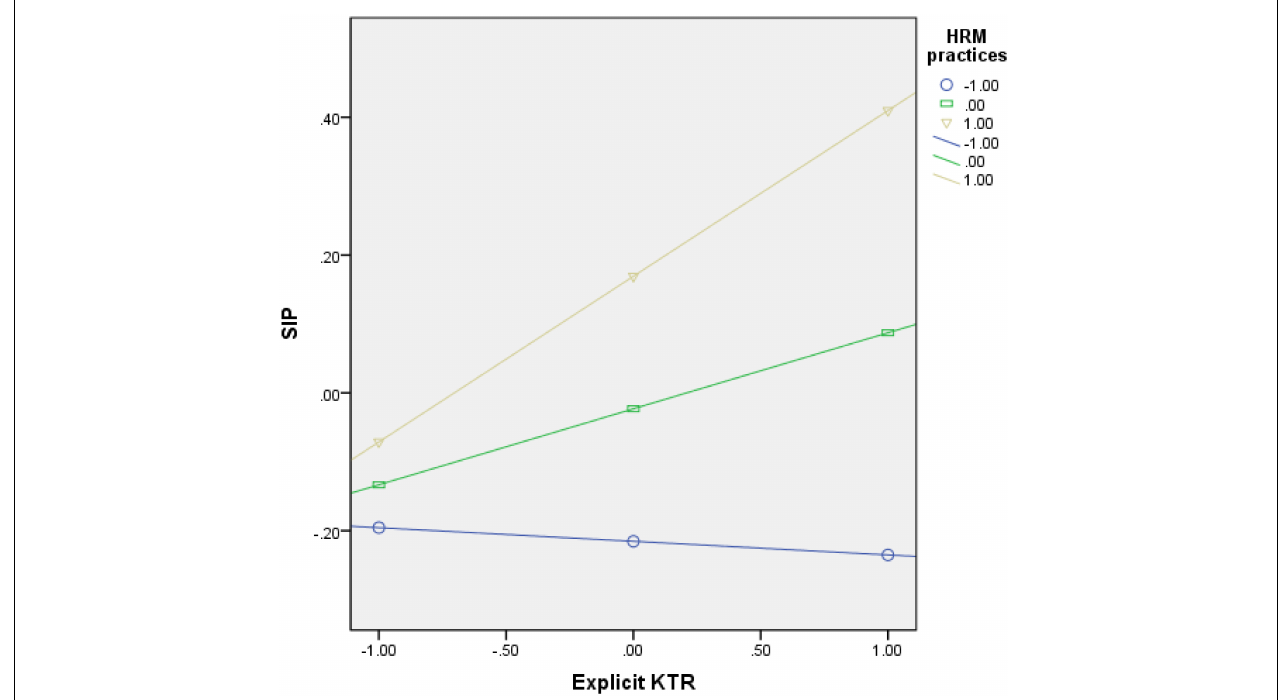
FIGURE 3 | The moderating effects of HRM Practices on the impact of explicit KTR and SIP.